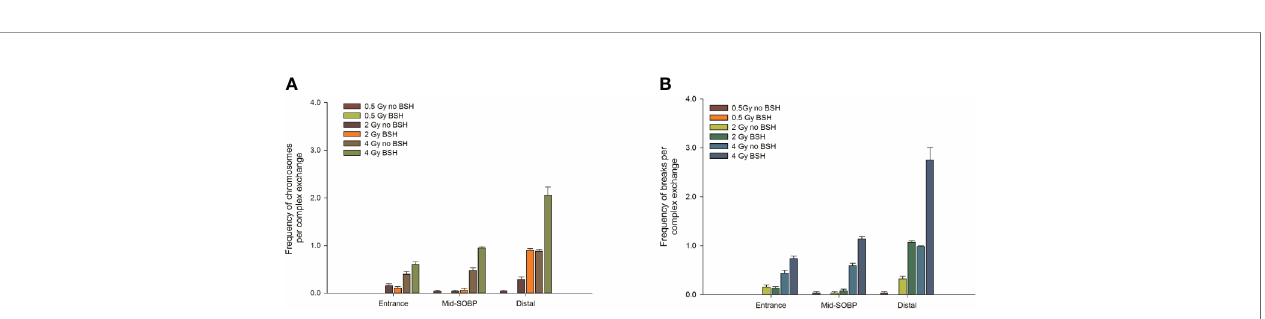
FIGURE 10 | Classi fi cation of complex exchanges revealed by mFISH analysis in terms of frequencies of number of chromosomes, left panel (A) , and number of breaks [right panel (B) ] involved; for MCF-10A cells irradiated at entrance, mid, and distal positions of the CNAO clinical proton beam.